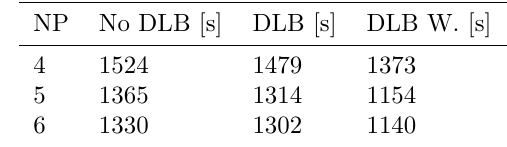
Table 2. Execution times comparing solutions with estimated processing weights (DLB W.), uniform pro- cessing weights (DLB) and without a load balancing (No DLB) framework (Intel i3 - 2 computing units + Intel i7 - 4 computing units).